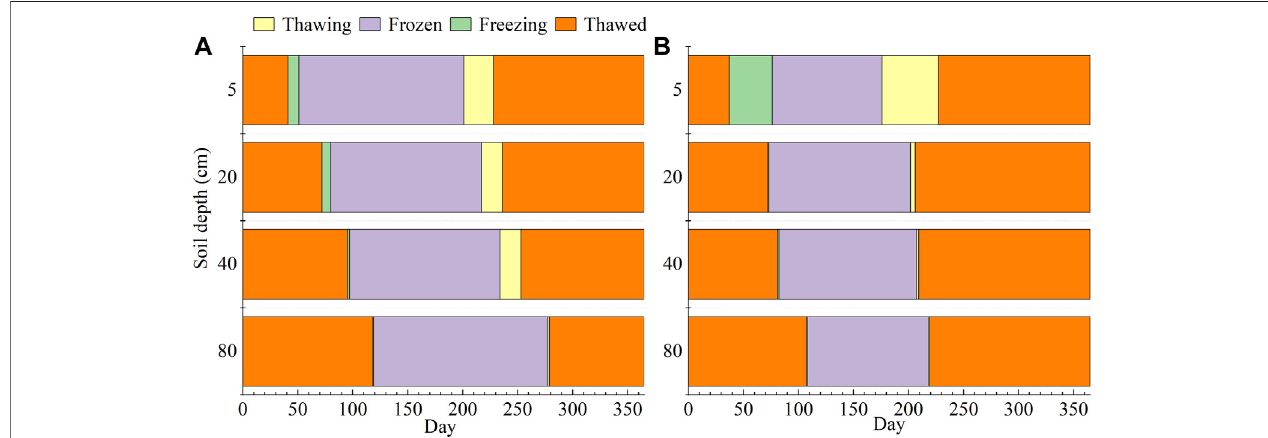
FIGURE 5 | Soil temperature contour map of two sites: (A) TS-04 site and (B) TS-05 site.